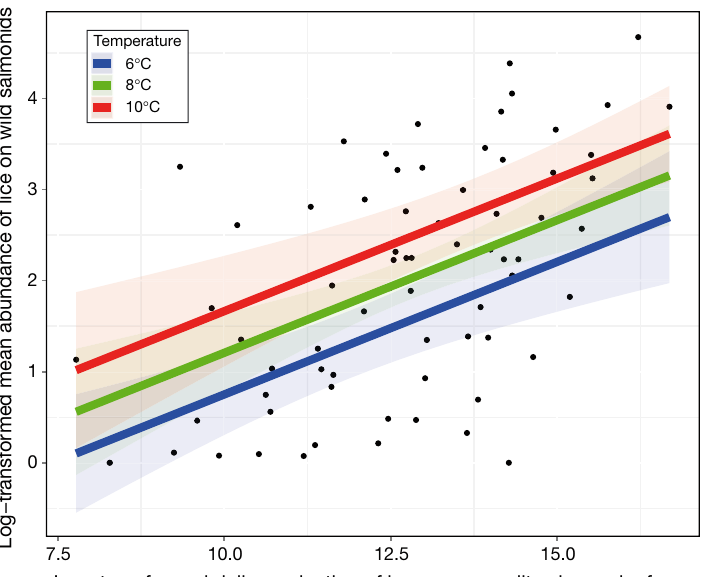
Fig. 1. Predicted mean abundances (fitted values with 95% CI) of lice (all stages) on wild salmonids as a function of the infestation pressure imposed by nearby farms (expressed as daily production of copepodites, calculated as explained in Serra-Llinares et al. 2014) at 3 different